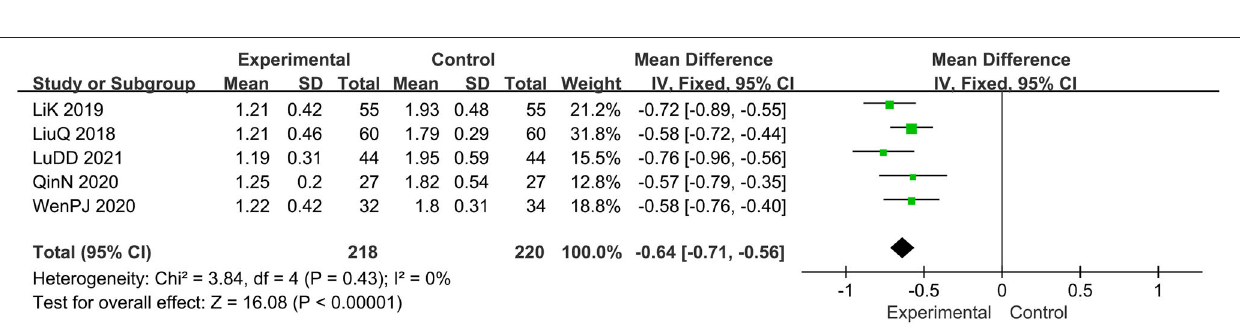
FIGURE 7 | The meta-analysis for comparison of combination therapy vs. prednisone for the outcome of the score of desquamation.